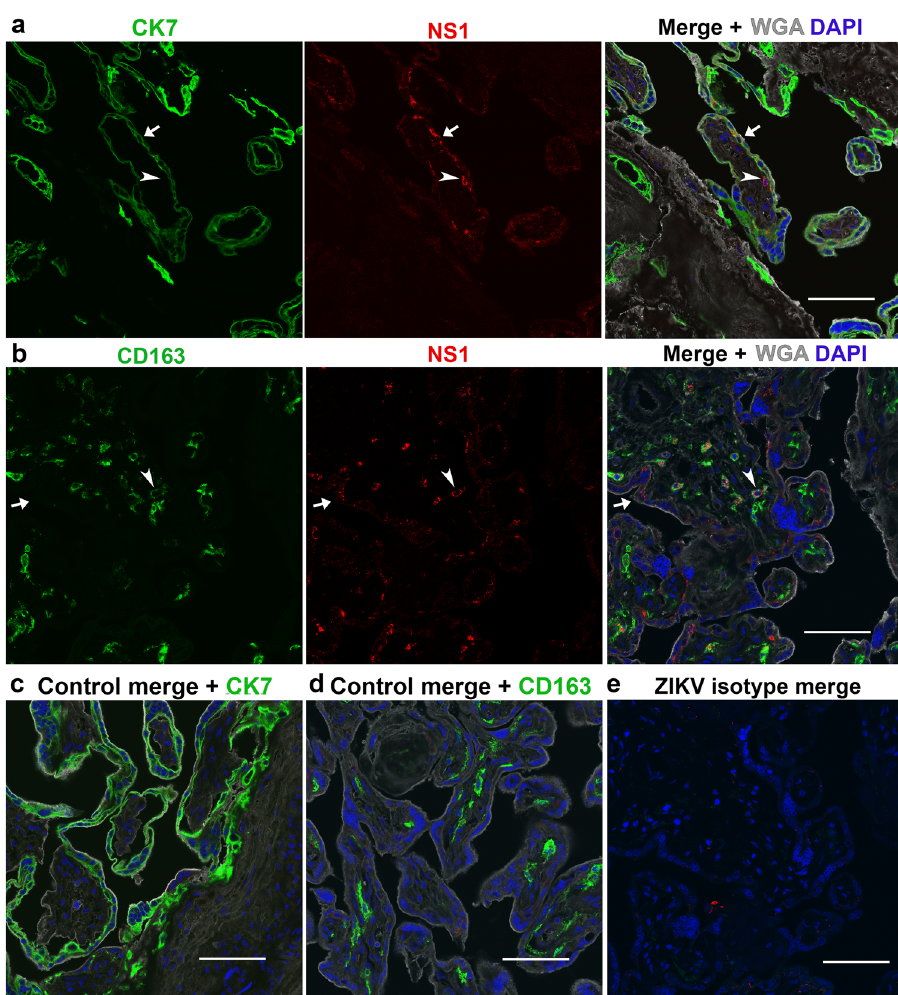
Fig. 3 NS1 colocalization in ZIKV perfused cotyledons. a – b Confocal images acquired from cotyledons exposed to ZIKV. Sections were stained with Cytokeratin 7 (CK7) or CD163 depicted in green, along with NS1 in red, the lectin WGA in gray and DAPI as blue. Arrows denote colocalization of NS1 with CK7 or CD163 positive cells, respectively. Arrowheads denote NS1 staining that does not colocalize. c – d Merged images of NS1, WGA, DAPI, and CK7 or CD163 staining ’ s in control cotyledons perfused in parallel to ZIKV. e Representative image of serial sections from ZIKV exposed sample stained with IgG isotype antibodies in place of anti-CK7, CD163 and NS1. Scale bars = 50 µ